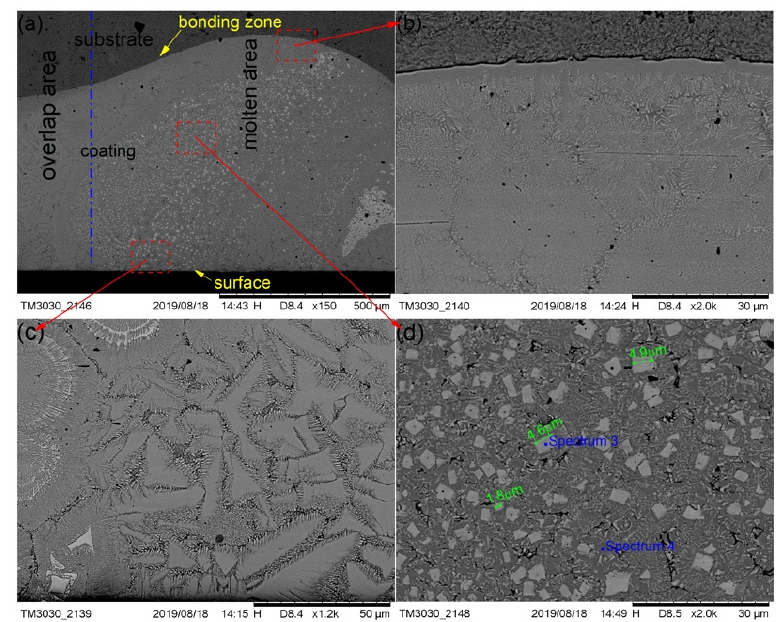
Figure 5. SEM morphology of the cermet coatings at 2500 W: ( a ) low magnification; ( b ) bonding zone at high magnification; ( c ) surface area at high magnification; ( d ) middle area at high magnification.